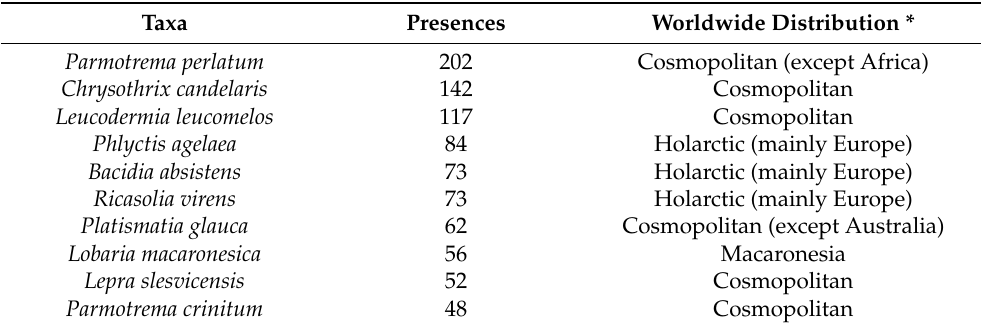
Table 6. Ten most frequent monteverde species and their absolute presences and worldwide distribu- tion. * sensu Ref. [65]. Taxa Presences Worldwide Distribution * Parmotrema perlatum 202 Cosmopolitan (except Africa) Chrysothrix candelaris 142 Cosmopolitan Leucodermia leucomelos 117 Cosmopolitan Phlyctis agelaea 84 Holarctic (mainly Europe) Bacidia absistens 73 Holarctic (mainly Europe) Ricasolia virens 73 Holarctic (mainly Europe) Platismatia glauca 62 Cosmopolitan (except Australia) Lobaria macaronesica 56 Macaronesia Lepra slesvicensis 52 Cosmopolitan Parmotrema crinitum 48